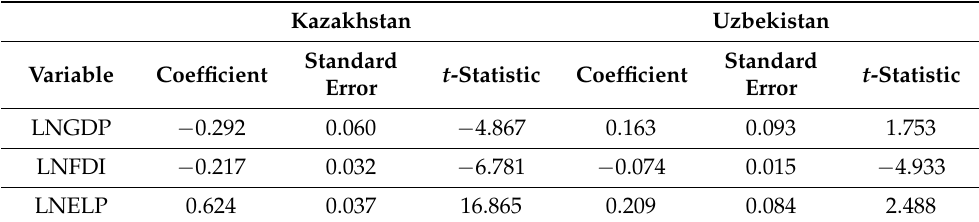
Table 4. Long-term equation with lnRW as a dependent